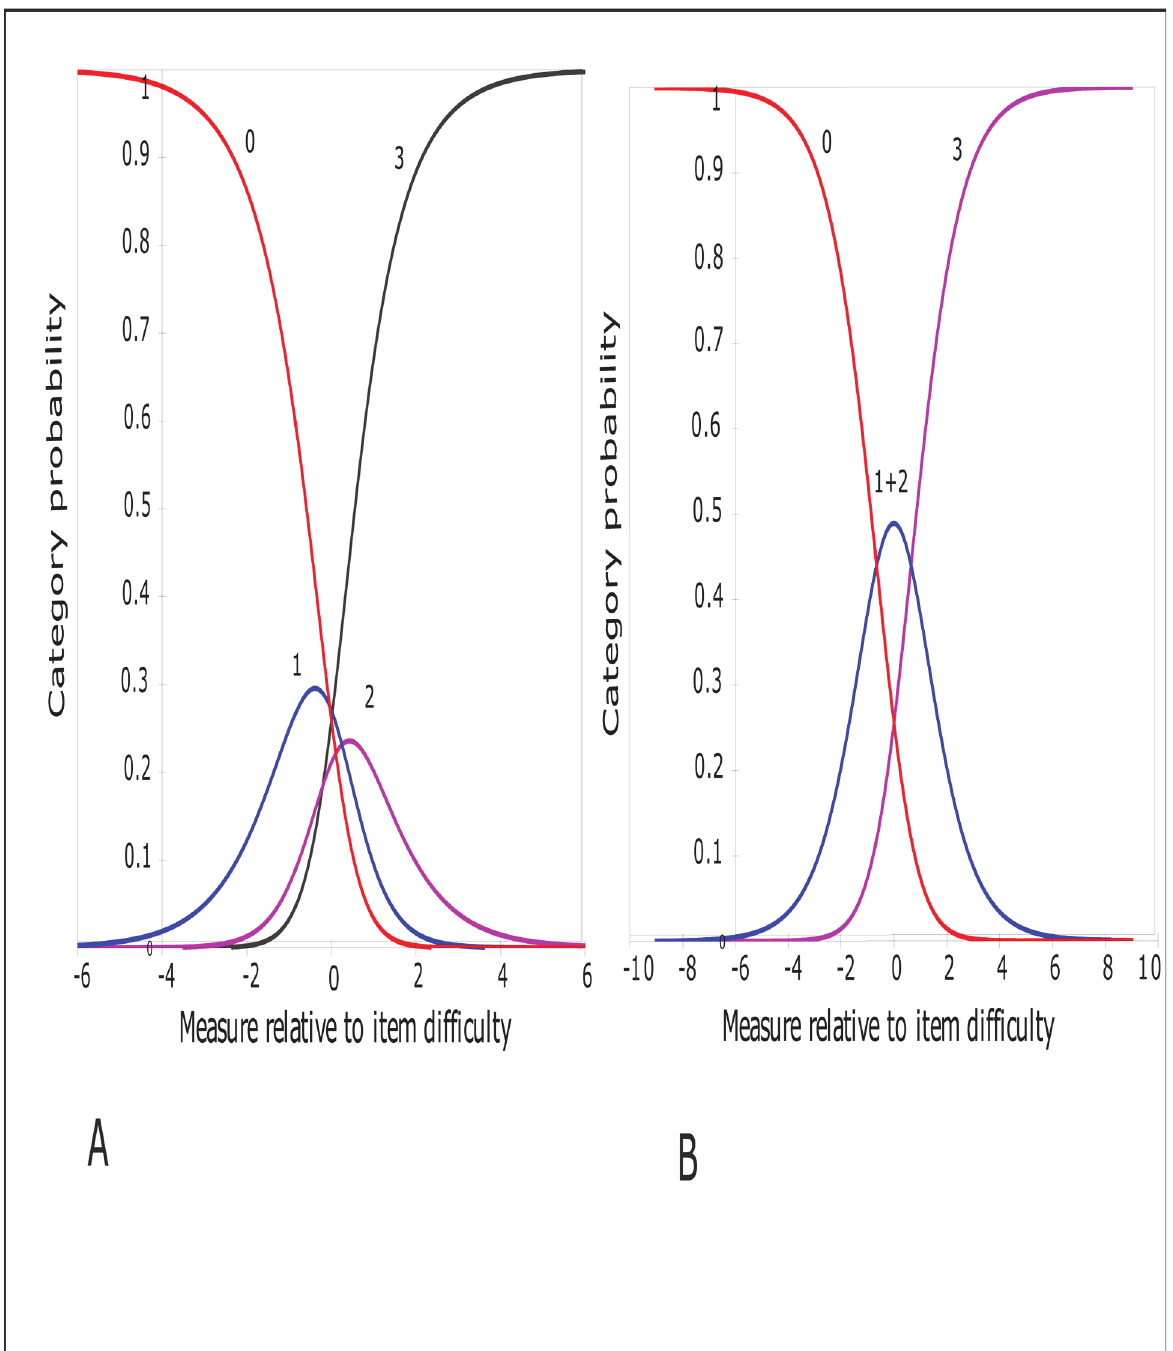
Fig 1. Rasch model category probability curves for all items together in the CHIP showing the likelihood that a participant with a particular coping ability will select a category. The scale ( x -axis) from +6 to-6 symbolizes the latent trait of coping and the y -axis represents the probability of category being selected. Response categories: 0 “ not helpful ” , 1 “ minimally helpful ” , 2 “ moderately helpful ” , and 3 “ extremely helpful ” . For any given point along this scale, the category most likely to be chosen by a participant is shown by the category curve with the highest probability. At no point, was category 2 the most likely to be chosen, resulting in disordered thresholds (A). Thresholds represent boundaries along the scale where the probability of a response category being chosen changes from one to the next. However, combining categories 1 and 2, and thereby reducing the number of categories from 4 to 3 repaired the disordered thresholds for the category probability curves